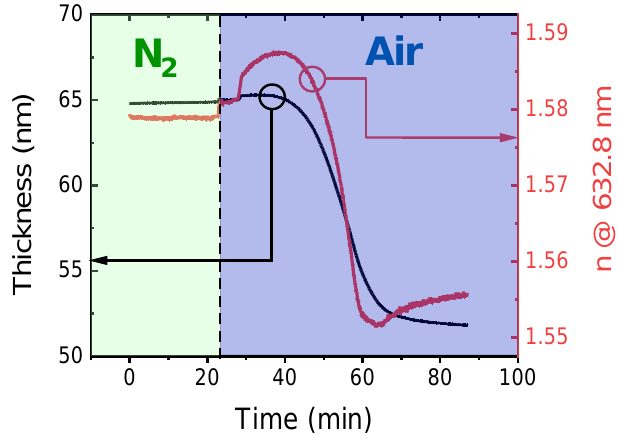
Figure 9. Zinc organic hybrid film degradation: Thickness and refractive index measured upon exposure to nitrogen (t < 22 min) and ambient air (t > 22 min).